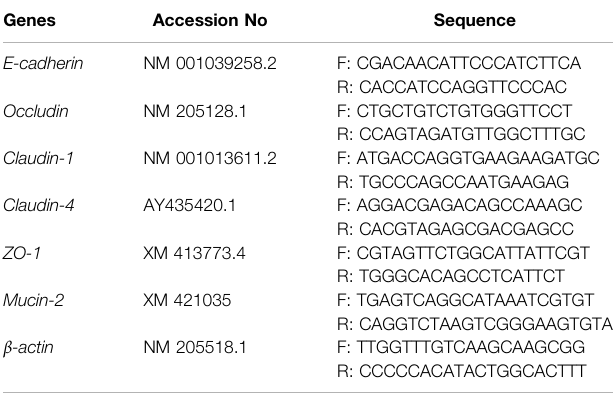
TABLE 1 | Nucleotide sequences of the speci fi c primers used in real-time qPCR analyses.